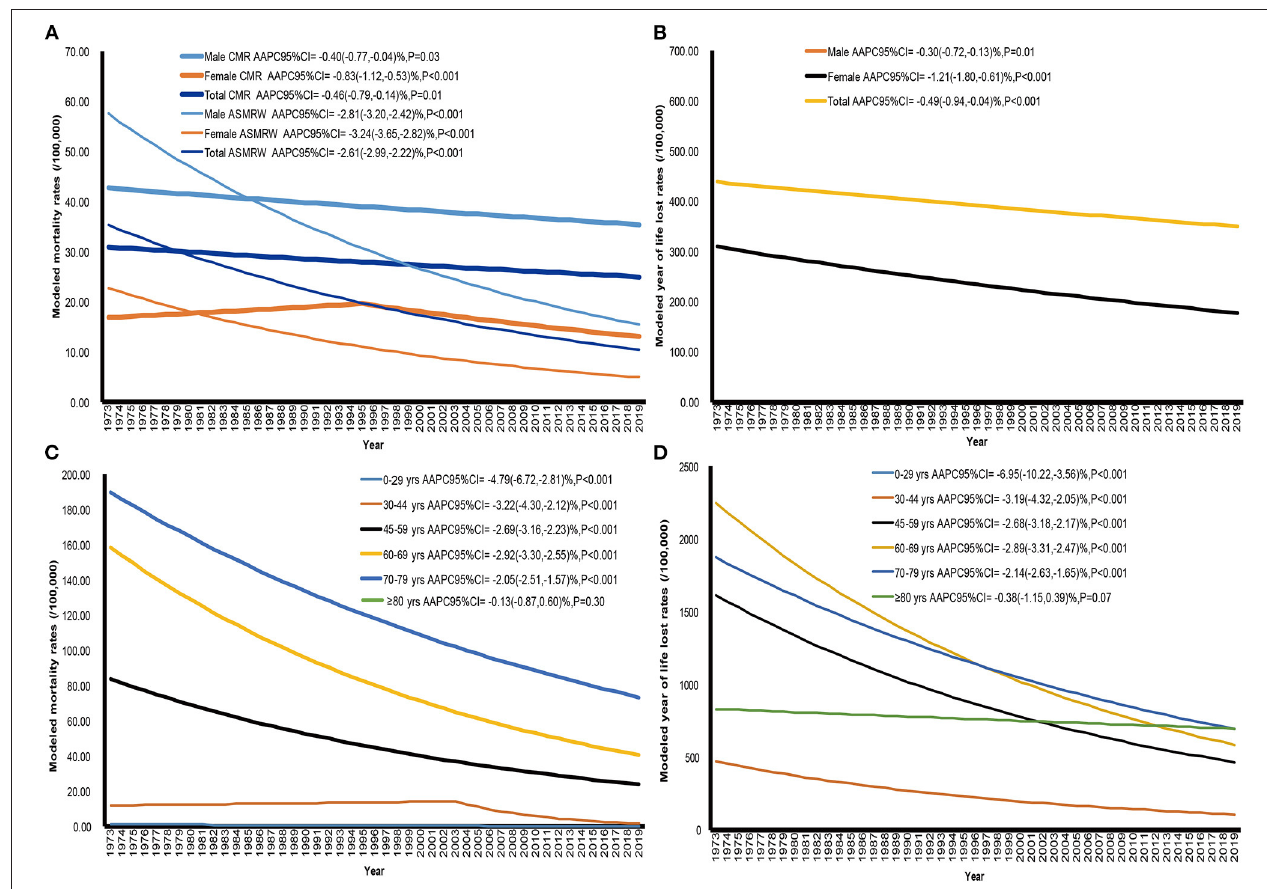
FIGURE 1 | The trends of CMR, ASMRW, and YLL rate of persons with underlying cause of liver cancer death in genders and age groups in Pudong New Area, Shanghai, from 1973 to 2019. (A) CMR and ASMRW in genders, (B) YLL rate in genders, (C) CMR in age groups, (D) YLL rate in age groups. ASMRW, age-standardized mortality rate by Segi’s world standard population (per 100,000); CMR, crude mortality rate (per 100,000); YLL, years of life lost (per